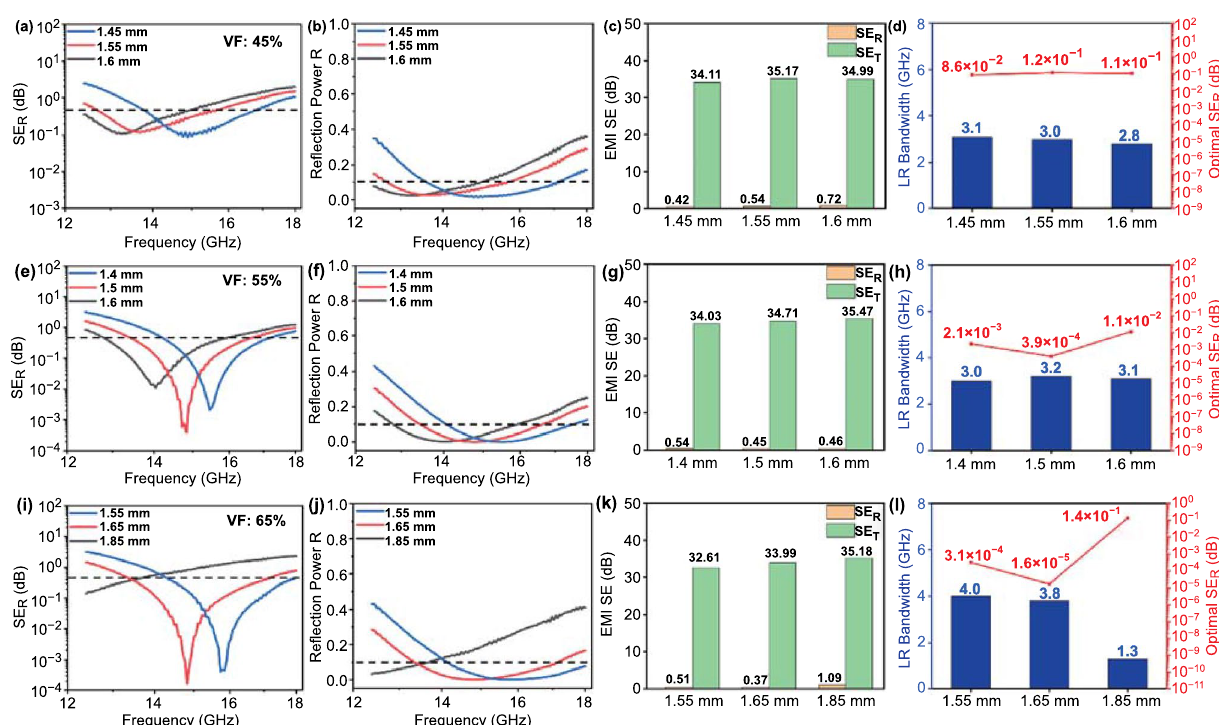
Fig. 6 EMI shielding performance of layered foam/film PVDF nanocomposites (30 wt% SiCnw@MXene7:1) corresponds to different matching thicknesses of absorption layer; a, e, i SE R ; b, f, j reflection power R; c, g, k average value of SE R and SE T ; d, h, l low reflection bandwidth and minimal SE R value. Dependence of the VF: a–d 45% VF; e–h 55% VF; and i–l 65%